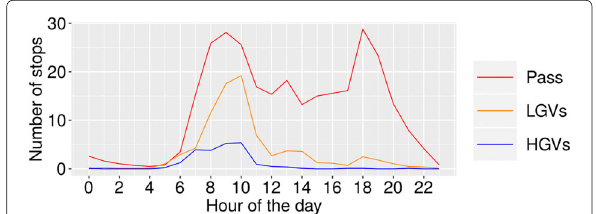
after which the stops has occurred. Figures 20, 21 and 22 show for passenger vehicles, LGVs and HGVs the cameras around which the stops have taken place. Frequencies in these visualizations show the averages on working days.